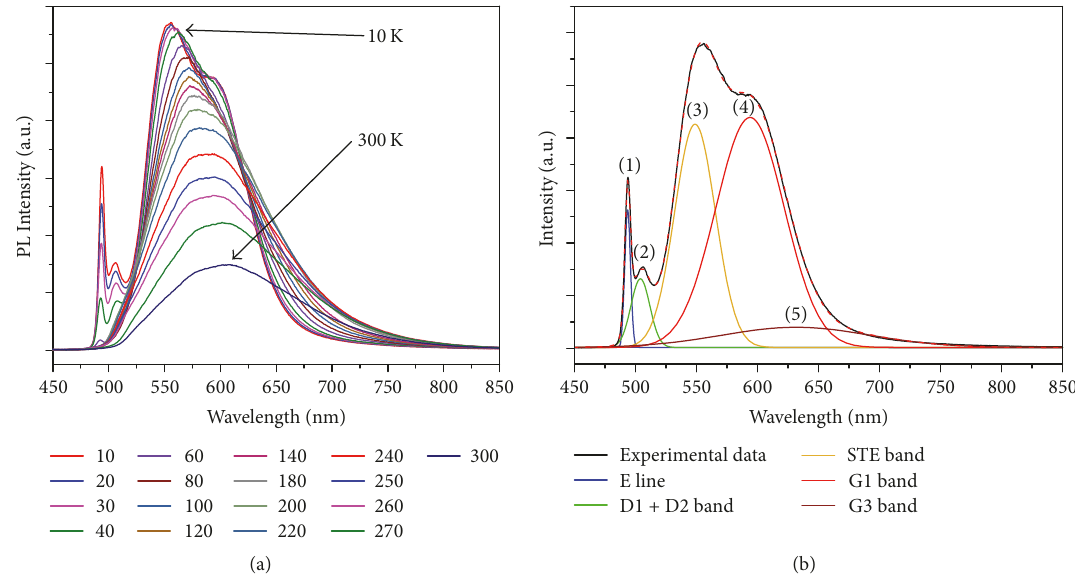
Figure 4: Temperature dependence of PL spectrum of PbCdI 2 thick films (a). Fitting the separate bands that form PL spectrum of PbCdI 2 thick films at 𝑇 = 10 K. PL bands that correspond to the radiative recombination of bound and free excitons (E), recombination of donor- acceptorpairsinvolvingshallowacceptorcenters(D1+D2),recombinationofself-trappedexcitons(STE),andrecombinationoffreeelectrons and the deep acceptor centers (G1 and G3) are observed (b). Curves 1–5 correspond to E, D1 + D2, STE, G1, and G3 bands, respectively. The red dashed curve represents the results of the fitting of the experimental data by the sum of Gaussian